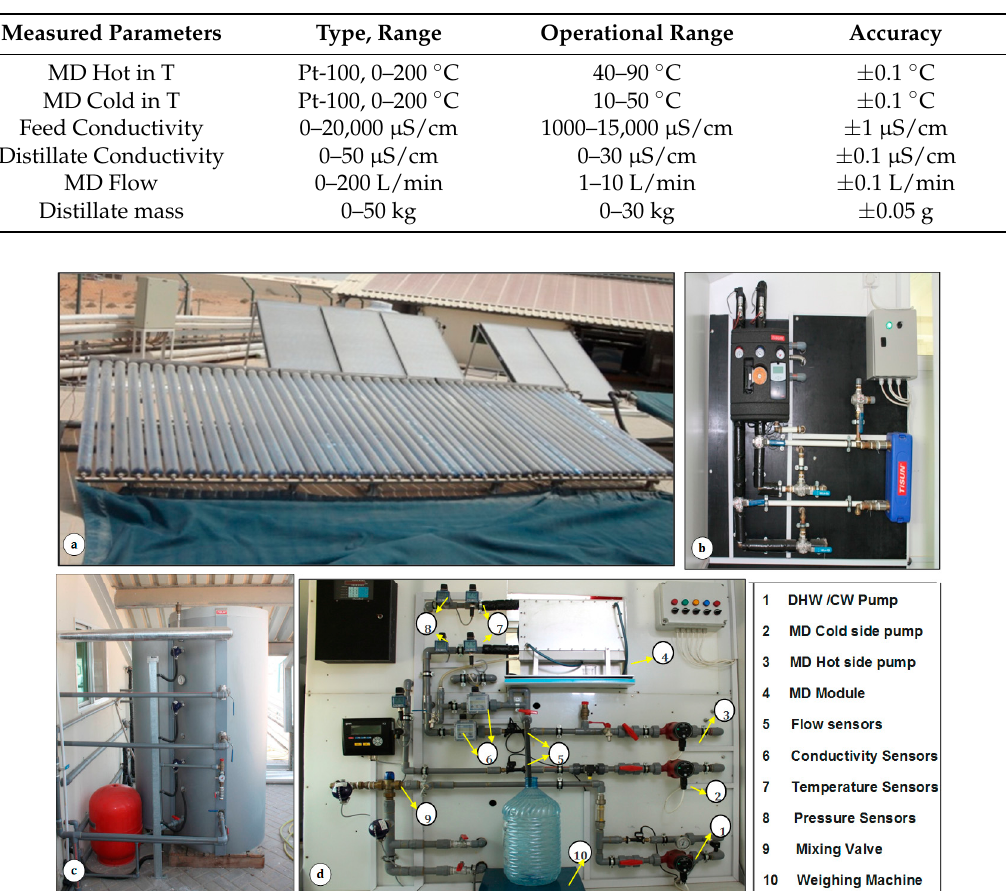
Figure 1. Pilot system installed at UAE: ( a ) flat plate and evacuated solar thermal collector arrays; ( b ) solar station circuit; ( c ) stratified thermal storage tank; and ( d ) MD module along with all instrumentation.